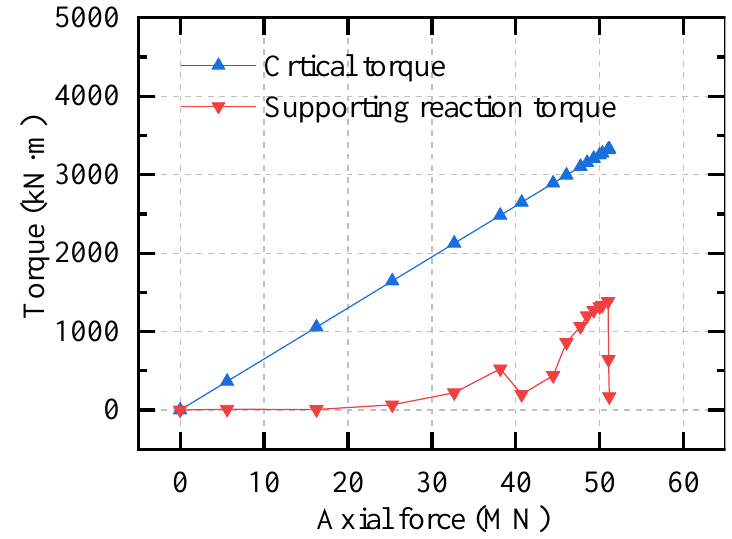
Figure 18. The critical torque and reaction torque under various conditions.